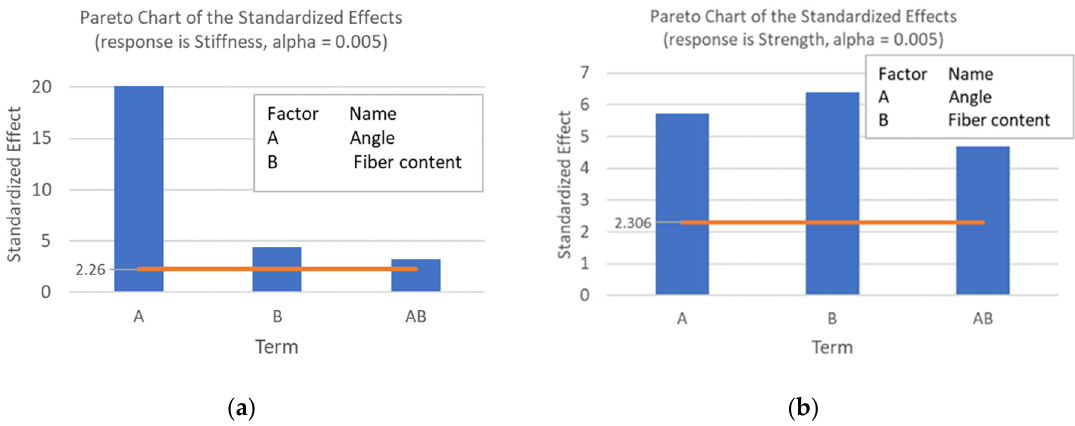
Figure 4. Pareto diagrams for the angle, fiber content, and interaction effects in the ( a ) stiffness and ( b ) strength.